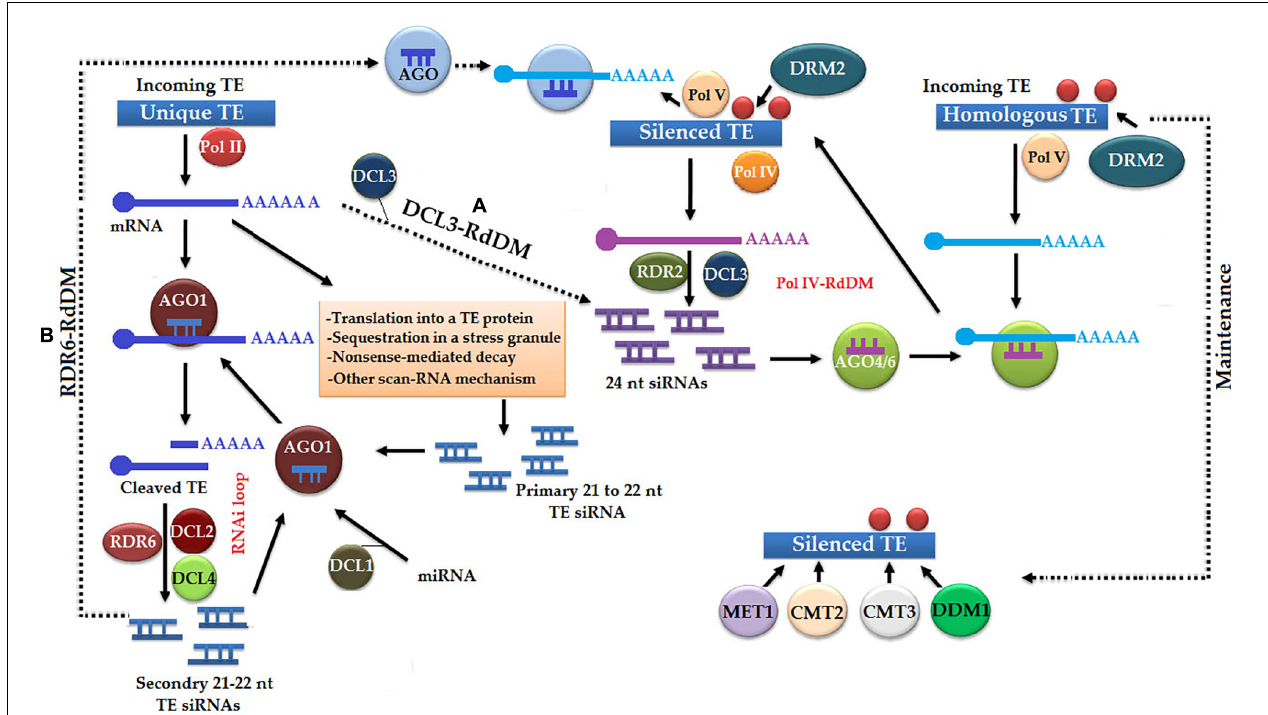
FIGURE 5 | Homology-independent initiation of silencing is a primary pathway, which is unleashed with the expression of unique transposable elements (TEs) under the action of Pol II and messenger RNA (mRNA) undergoing post-transcriptional silencing via RNA interference (RNAi). In this pathway gene, silencing occurs by the following methods: (A) Dicer homolog 3- (DCL3-) RdDM, in which 24-nt siRNAs play a major role in a homology-dependent pathway, and (B) RNA dependent RNA polymerase 6- (RDR6-) RdDM, in which AGO protein-based silencing complex causes the silencing of Pol V transcripts. Homology-dependent pathway, in which TEs are transcribed by Pol IV and digested into 24-nt siRNAs by RDR2 and DCL3, which subsequently bind with AGO4 or AGO6 to become active and interact with polymerase V scaffolding transcript resulted in transcriptional TE silencing. Finally, silencing state is restored with the help of methyltransferase 1 (MET1), chromomethylase 2 (CMT2), chromomethylase 3 (CMT3), and DECREASE IN DNA METHYLATION 1